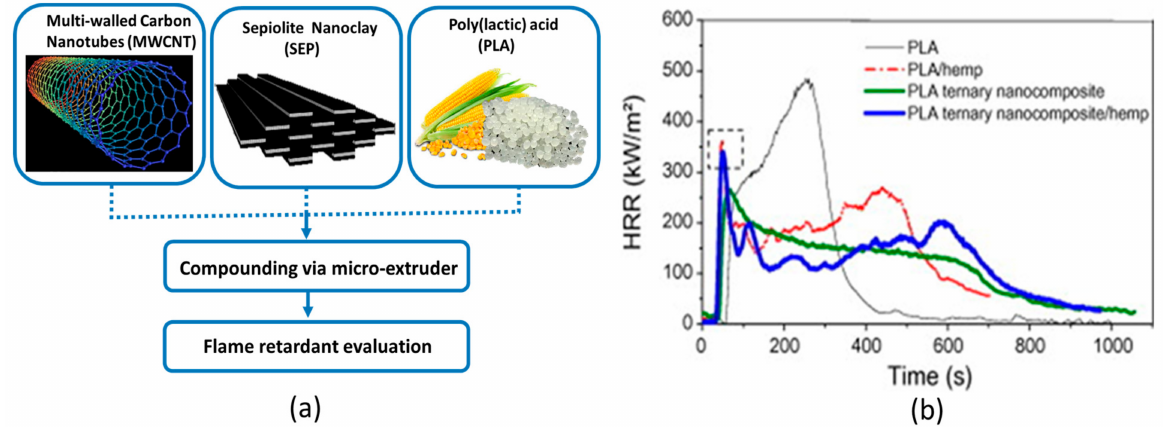
Figure 8. ( a ) Fabrication process of MWCNT/SEP/PLA composite (modified); and ( b ) PHRR of MWCNT/SEP/PLA composite (Adapted with permission from